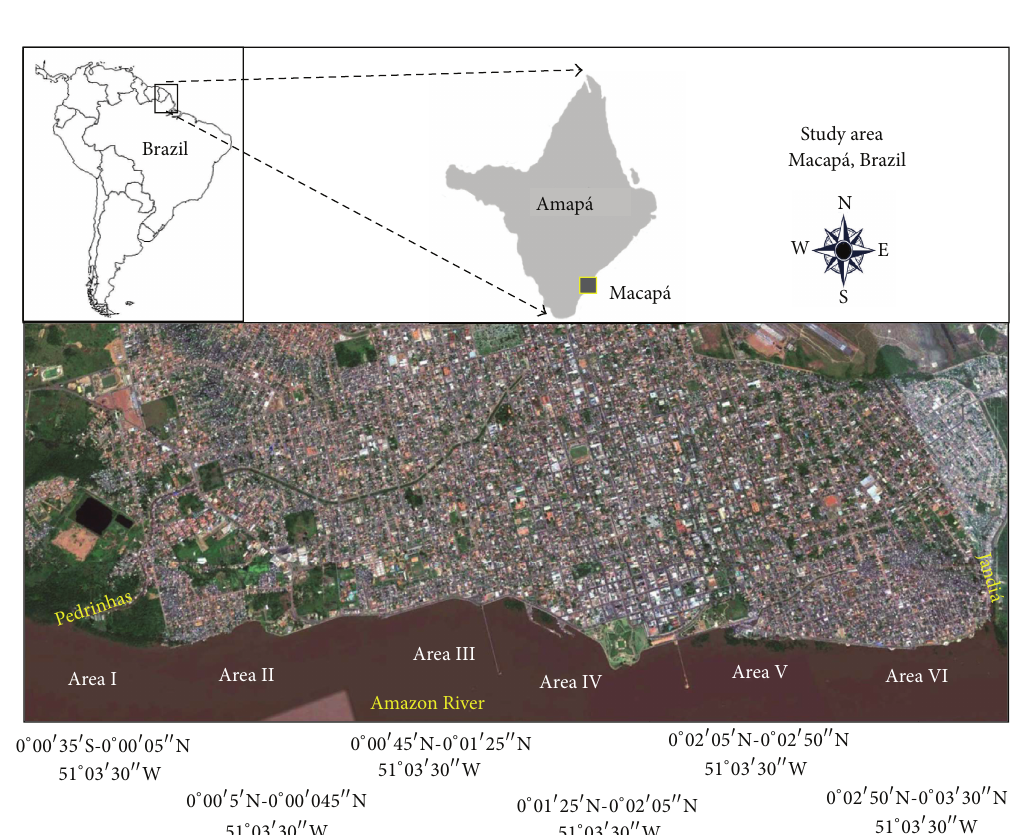
Figure 1: Study area: intertidal zone of the Amazon River on the waterfront of the city of Macap´a in Amap´a, Brazil. Source: Google